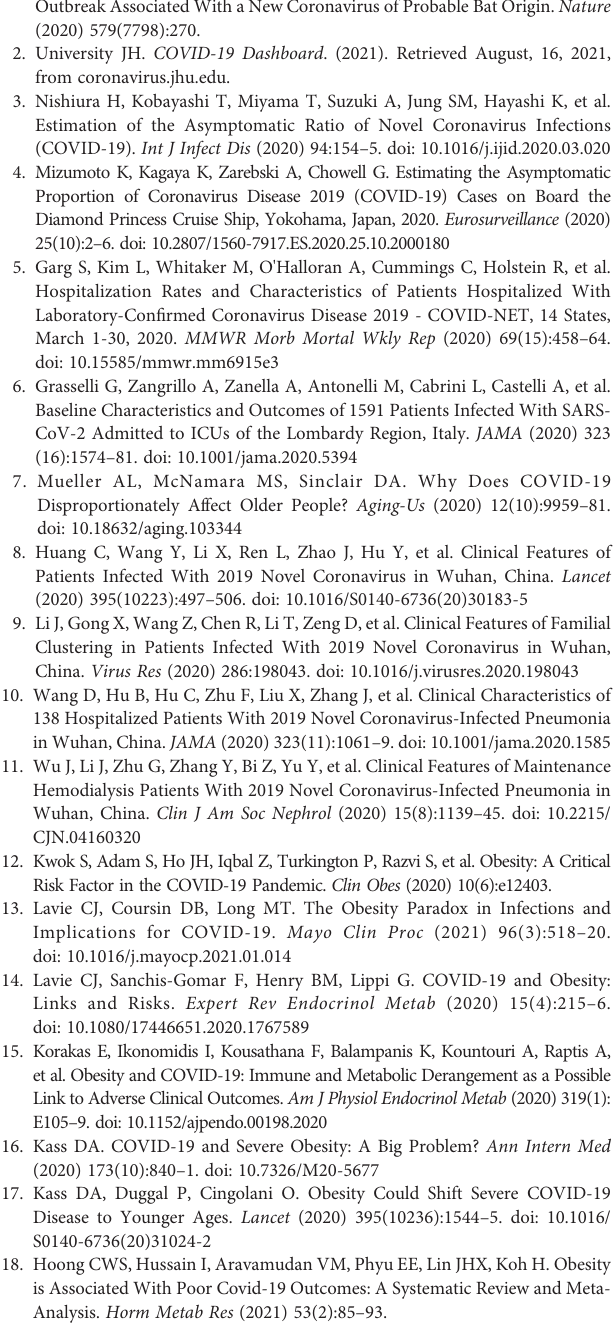
Supplementary Table 5 | Correlation and Simple linear regression values of the frequency of myeloid cell subsets secreting both TNF- a and IL-6 in response to a cocktail of bacterial agonists in young and aged patients. Supplementary Table 6 | Correlation and Simple linear regression values of the frequencyandproliferationoftheadaptiveimmunecellsubsetsinyoungandagedpatients.